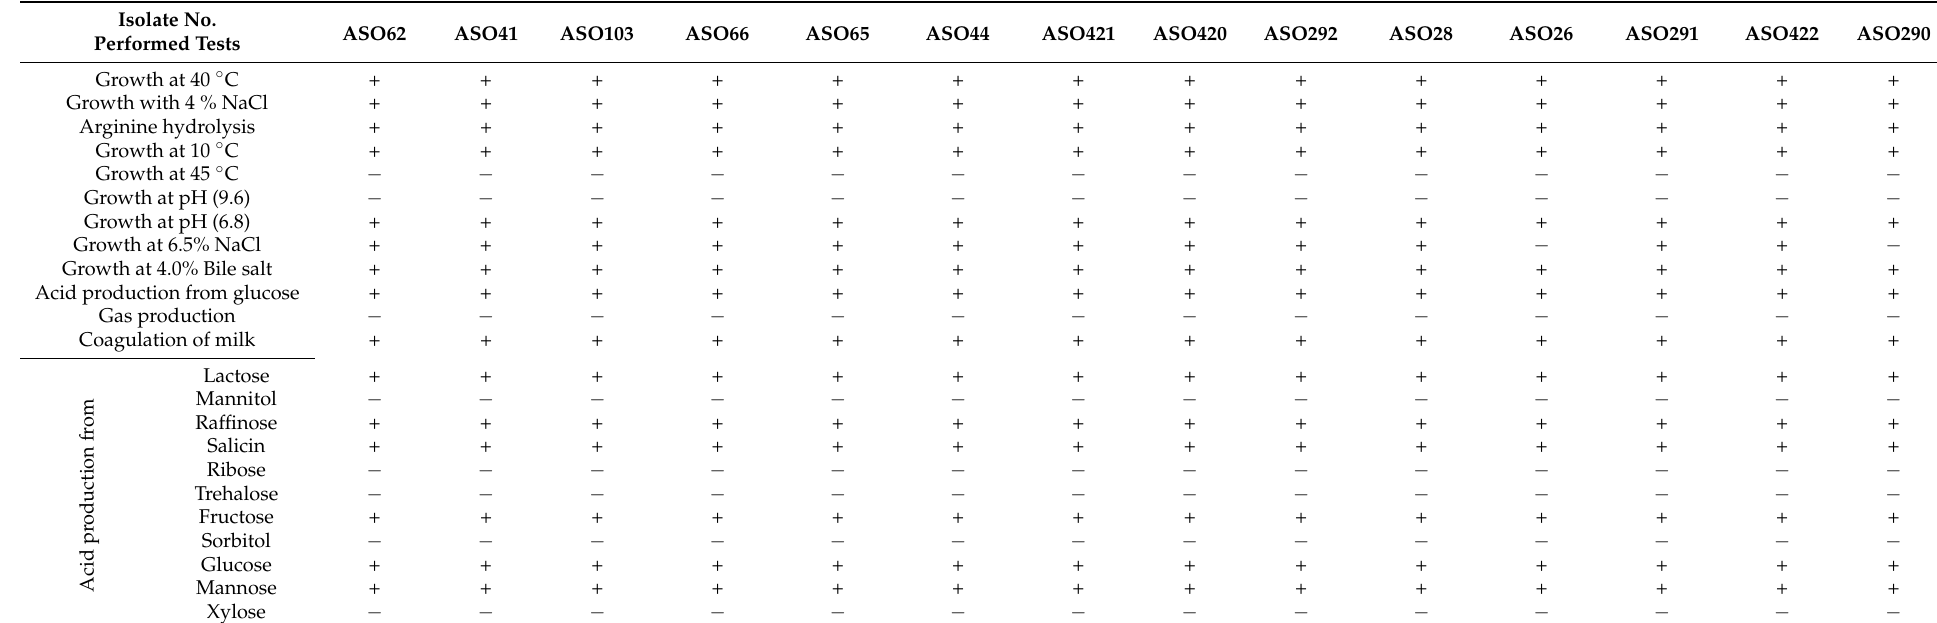
Table 2. Physiological and biochemical Characteristics of Cocci lactic acid